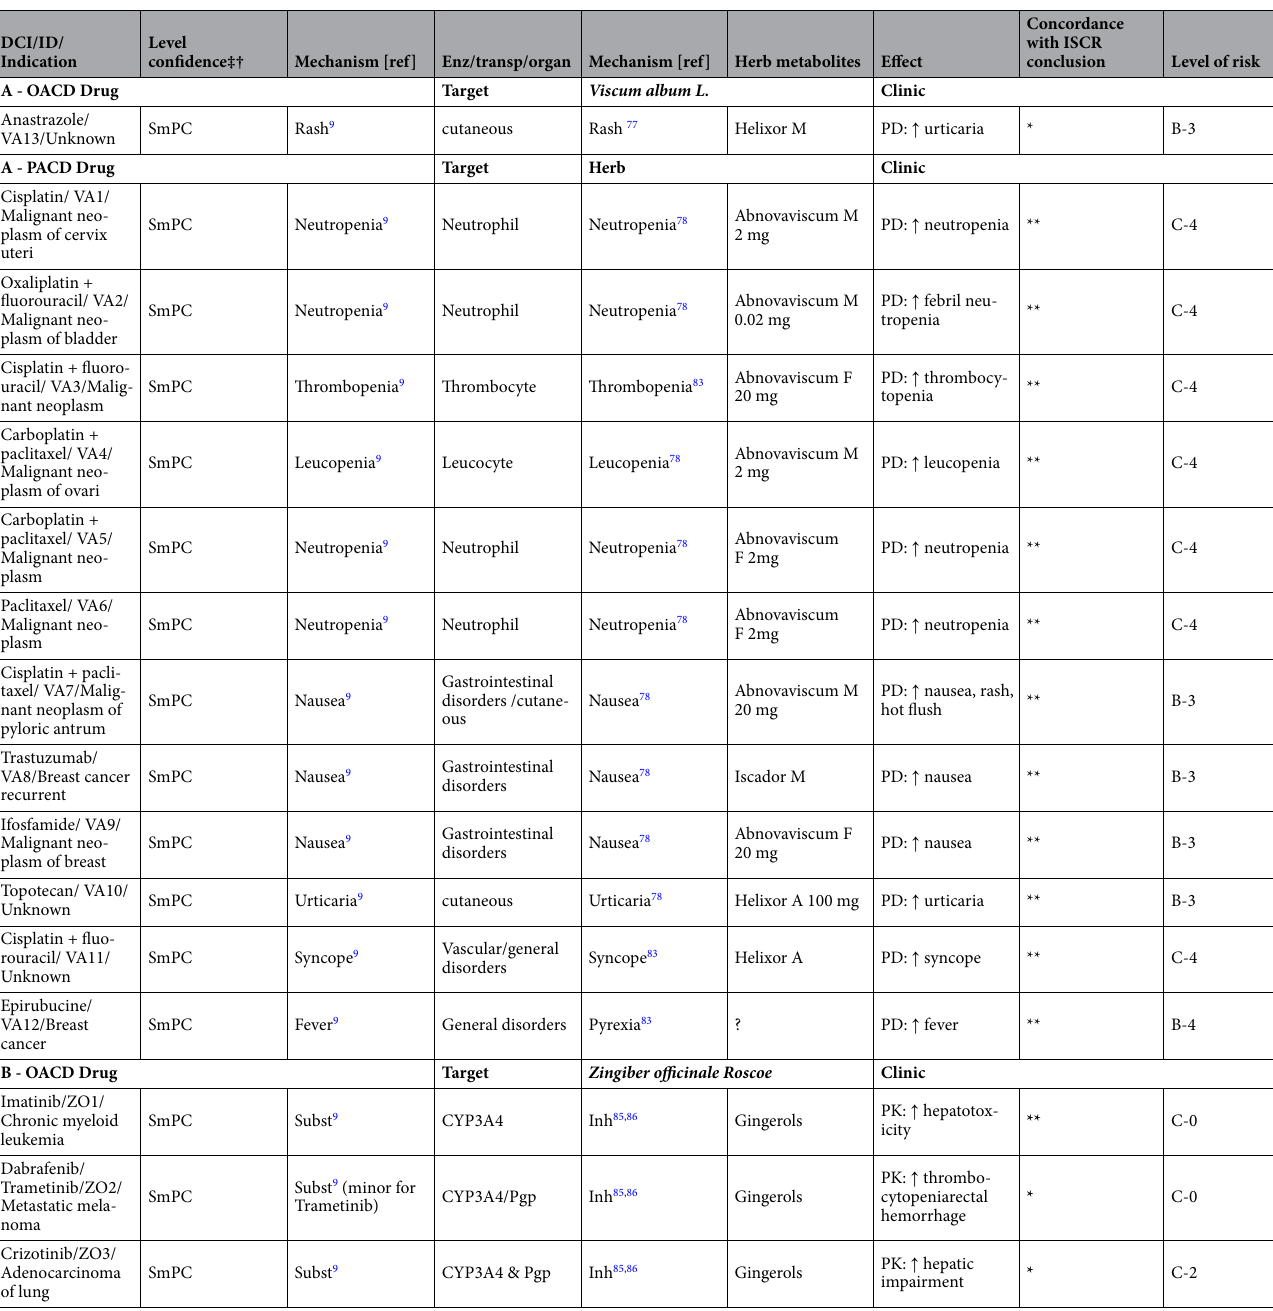
Table 6. (A) Viscum album L. & (B) Zingiber officinale Roscoe—ACD interactions among selected ICSRs. OACD: Oral Anti-cancer Drug; PACD: Parenteral Anti-cancer Drug ; PD: pharmacodynamic;